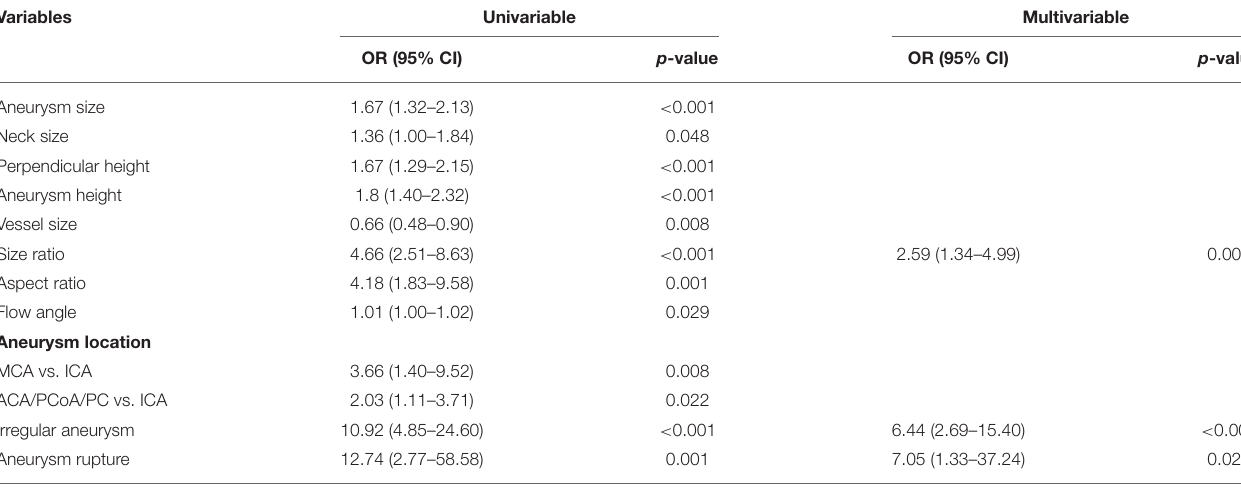
TABLE 5 | Univariate and multivariate analyses of predictors of irregular pulsation of small intracranial